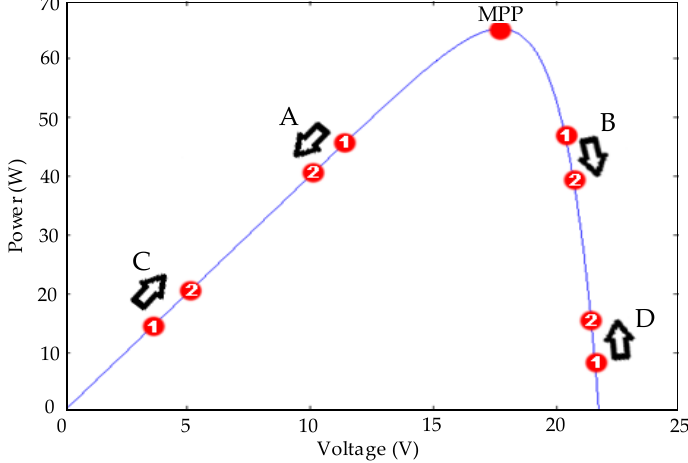
Figure 11. Movement of the maximum power point on the P-V curve of the PV module.